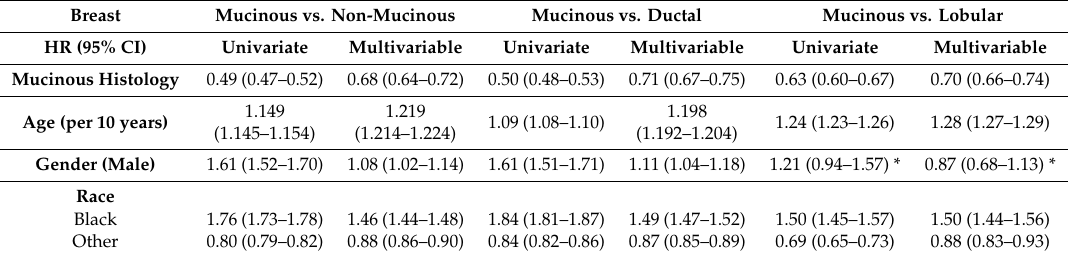
Table 4. Derived univariate and multivariable Cox-proportional hazard ratios (HR) of mortality for breast